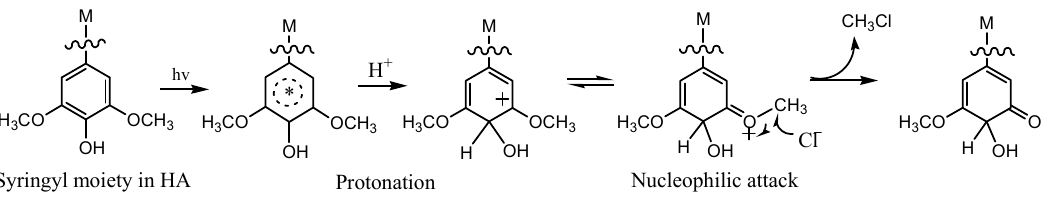
Figure 7. A possible formation pathway of CH 3 Cl from the syringyl moiety of HA under light Figure7. ApossibleformationpathwayofCH 3 irradiation.